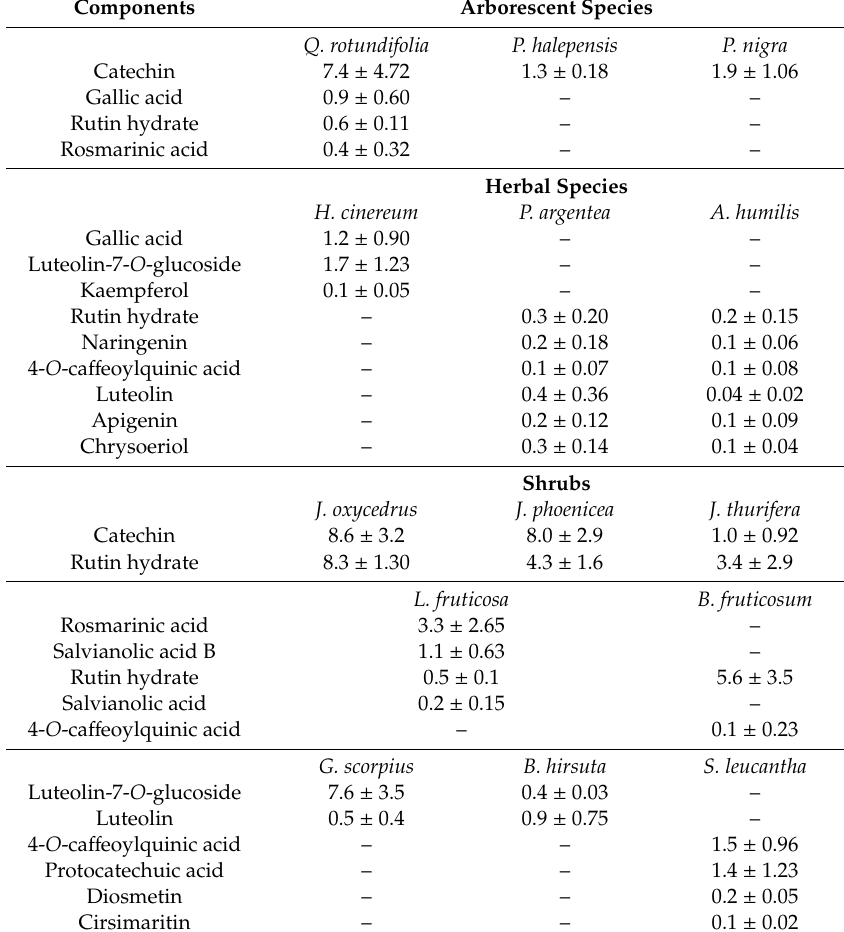
Table 2. Major polyphenolic components quantified in the species grazed by sheep (mg / g of dry plant).